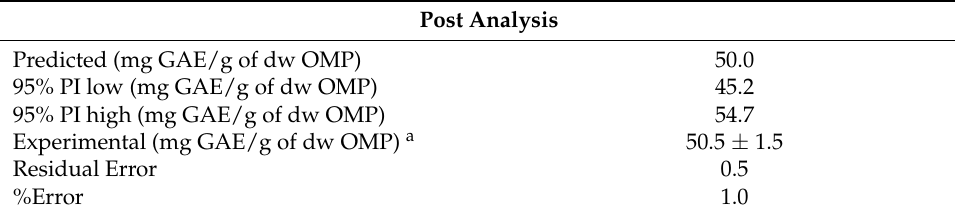
Table 4. Experimental and Post analysis of the response.